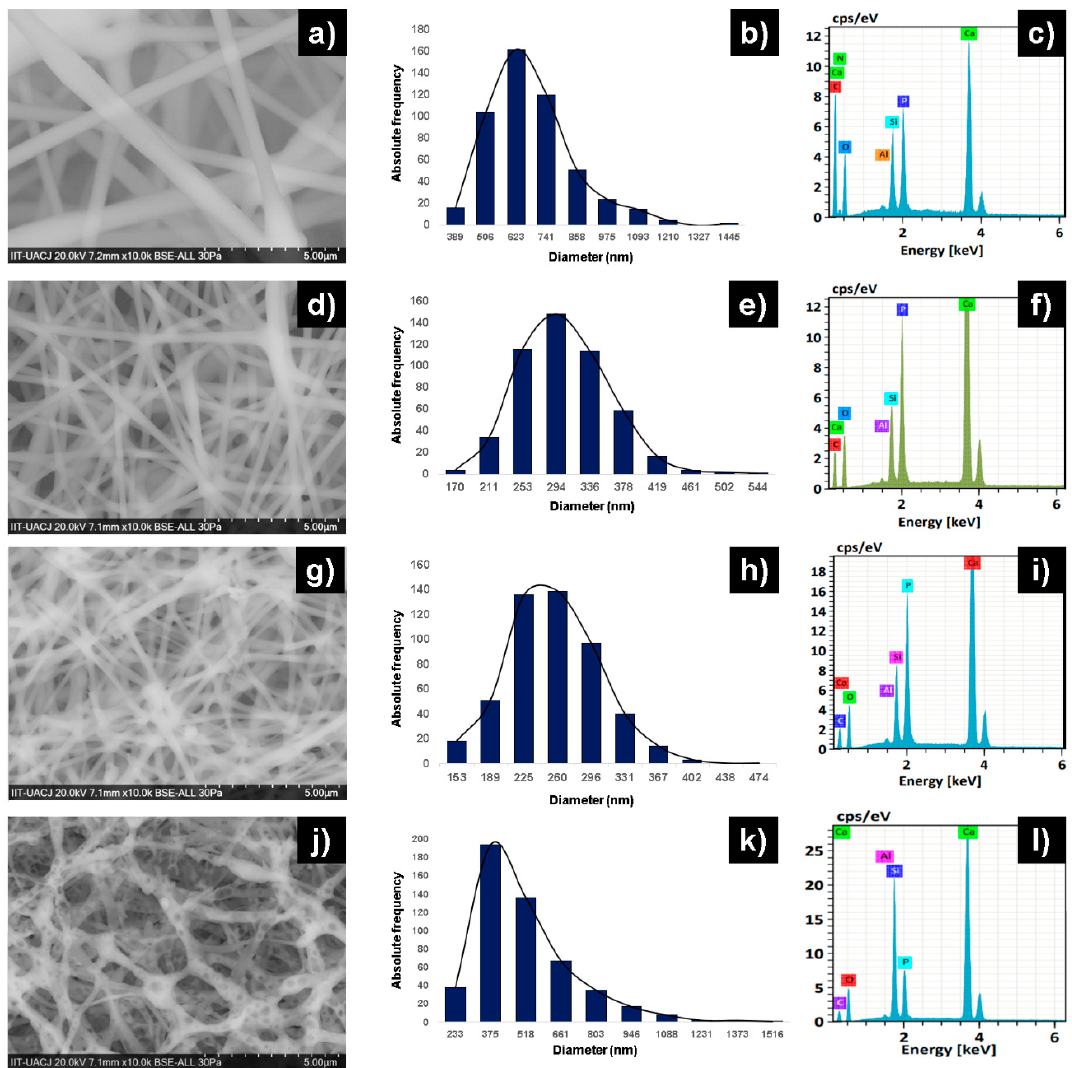
Figure 3. ( a ) Micrograph at 10,000 × , ( b ) diameter distribution plot and ( c ) EDS spectrum of the as-spun SiO 2 –HA–PVP fibers; ( d ) micrograph at 10,000 × , ( e ) diameter distribution plot and ( f ) EDS spectrum of the as-spun SiO 2 –HA–PVP fibers at 400 ◦ C; ( g ) micrograph at 10,000 × , ( h ) diameter distribution plot and ( i ) EDS spectrum of the as-spun SiO 2 –HA–PVP fibers at 800 ◦ C; ( j ) micrograph at 10,000 × , ( k ) diameter distribution plot and ( l ) EDS spectrum of the as-spun SiO 2 –HA–PVP fibers at 1150 ◦ C.